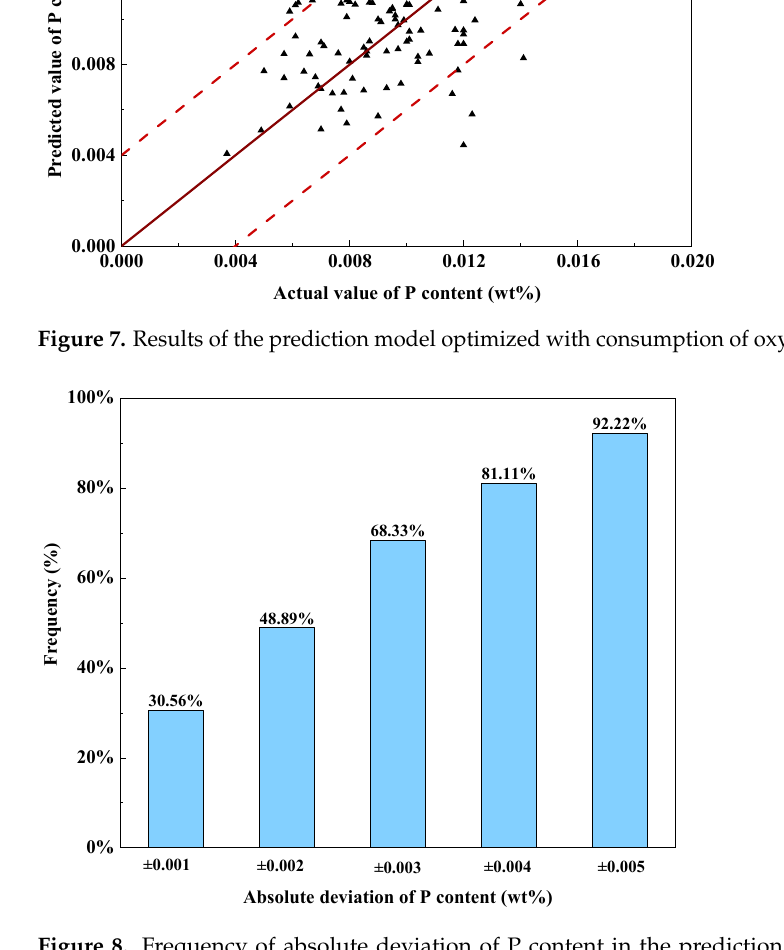
Figure 8. Frequency of absolute deviation of P content in the prediction model optimized with con- sumption of oxygen divided into stages.